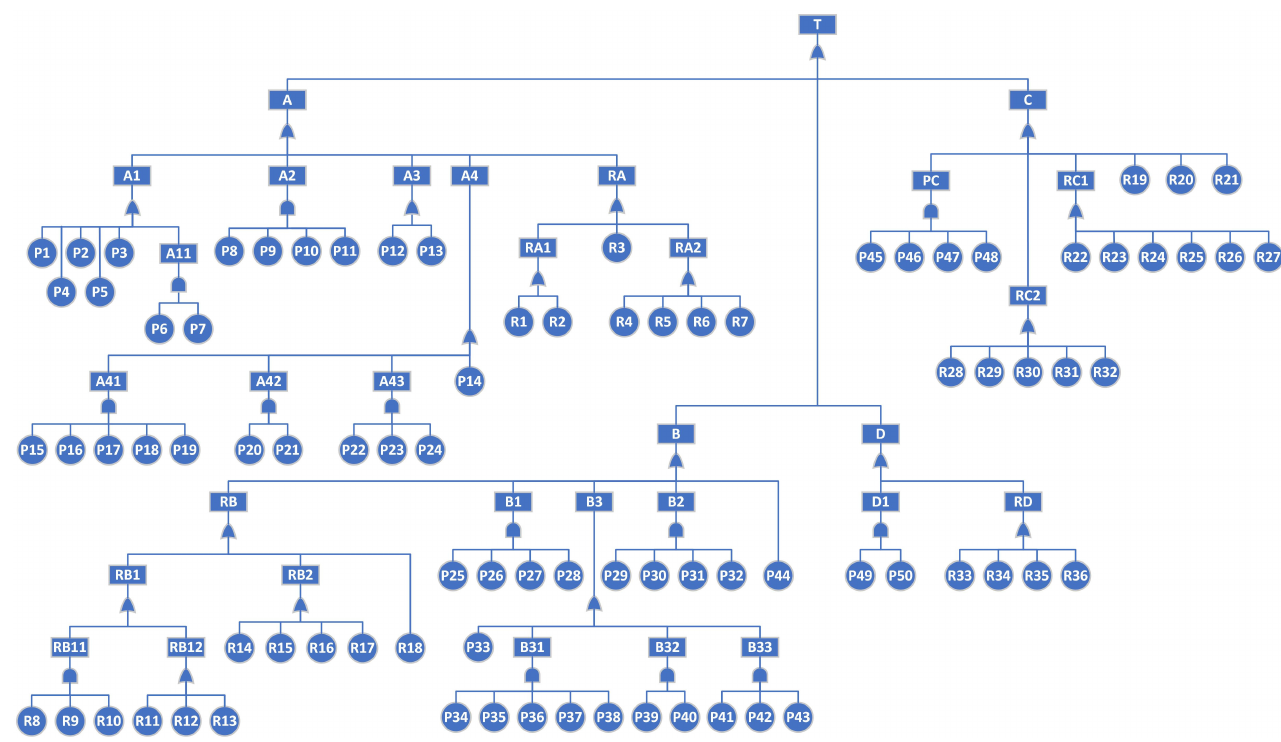
Figure 3. The design of a fault tree for